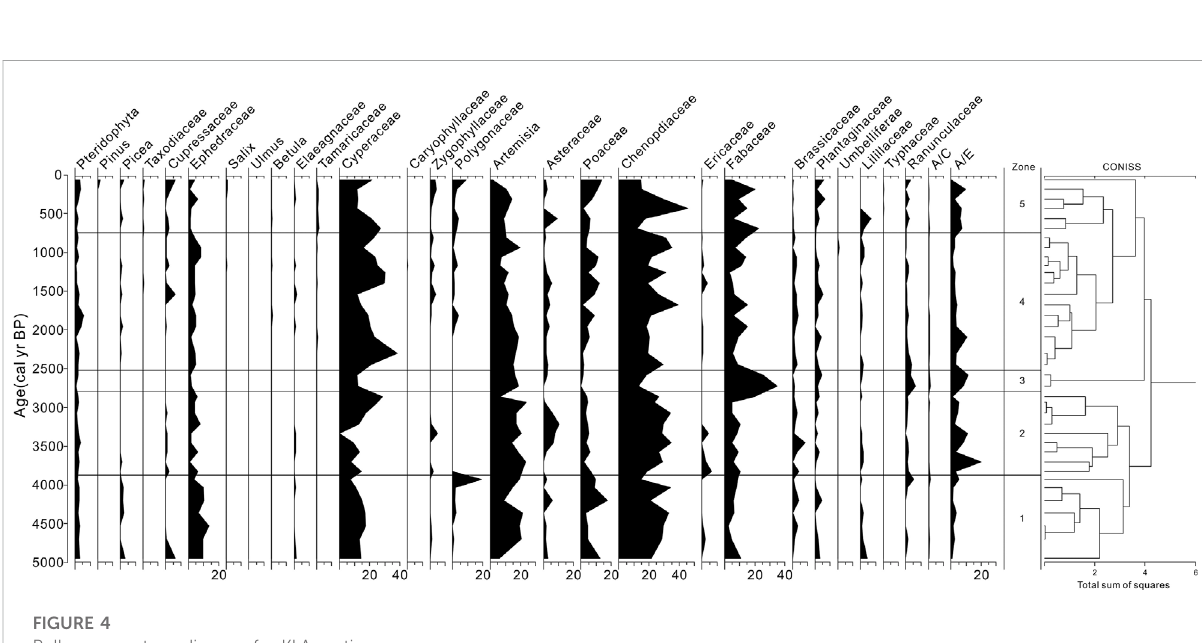
Pollen percentage diagram for KLA